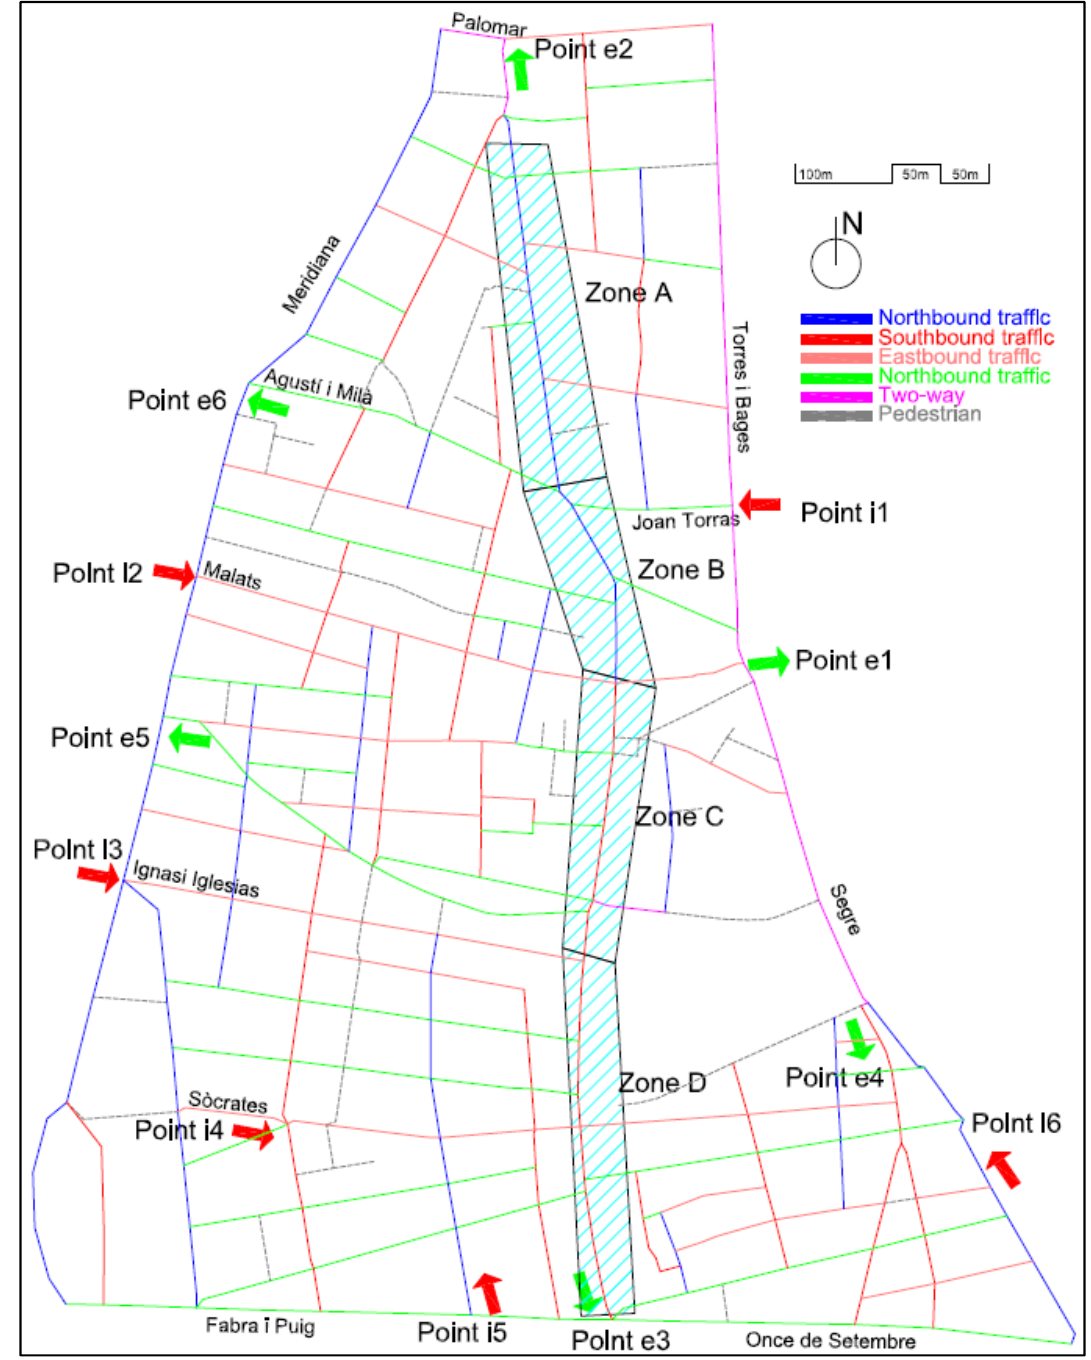
Figure 2. Historic center of the Sant Andreu del Palomar neighborhood. The pacification of the main street (shaded and identified by areas A, B, C, and D in Figure 2; also known as Gran Street) and the change of direction in the cycle (now the N direction) from Malats Street to Palomar Street (historically, it was completely in the S direction, like the rest of the street) constitute the starting point of the problem that affects other streets. The new direction of traffic by street is shown in Figure